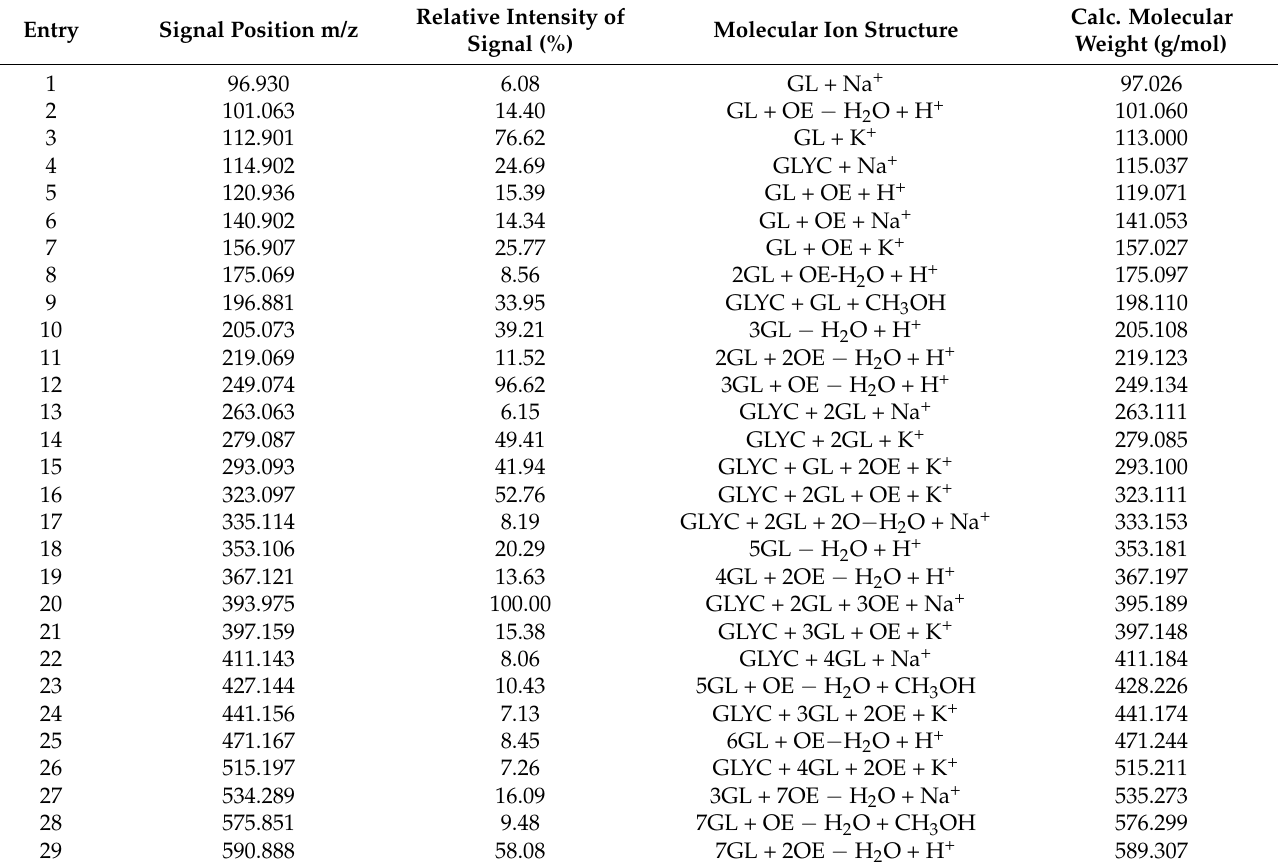
Table 3. Interpretation of MALDI-TOF spectrum of polyol (CS + GLYC + GL) + EC.